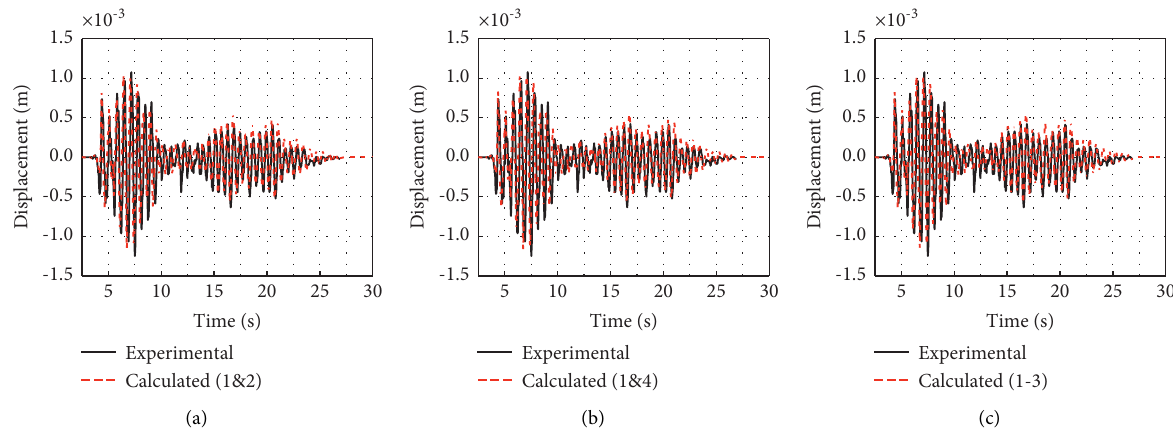
Figure 17: Displacement time histories of the first story by using different damping models (case 225): (a) RD with 1&2 frequencies of the isolated structure, (b) RD with 1&4 frequencies of the isolated structure, and (c) NP-CD with 1–3 frequencies of the nonisolated